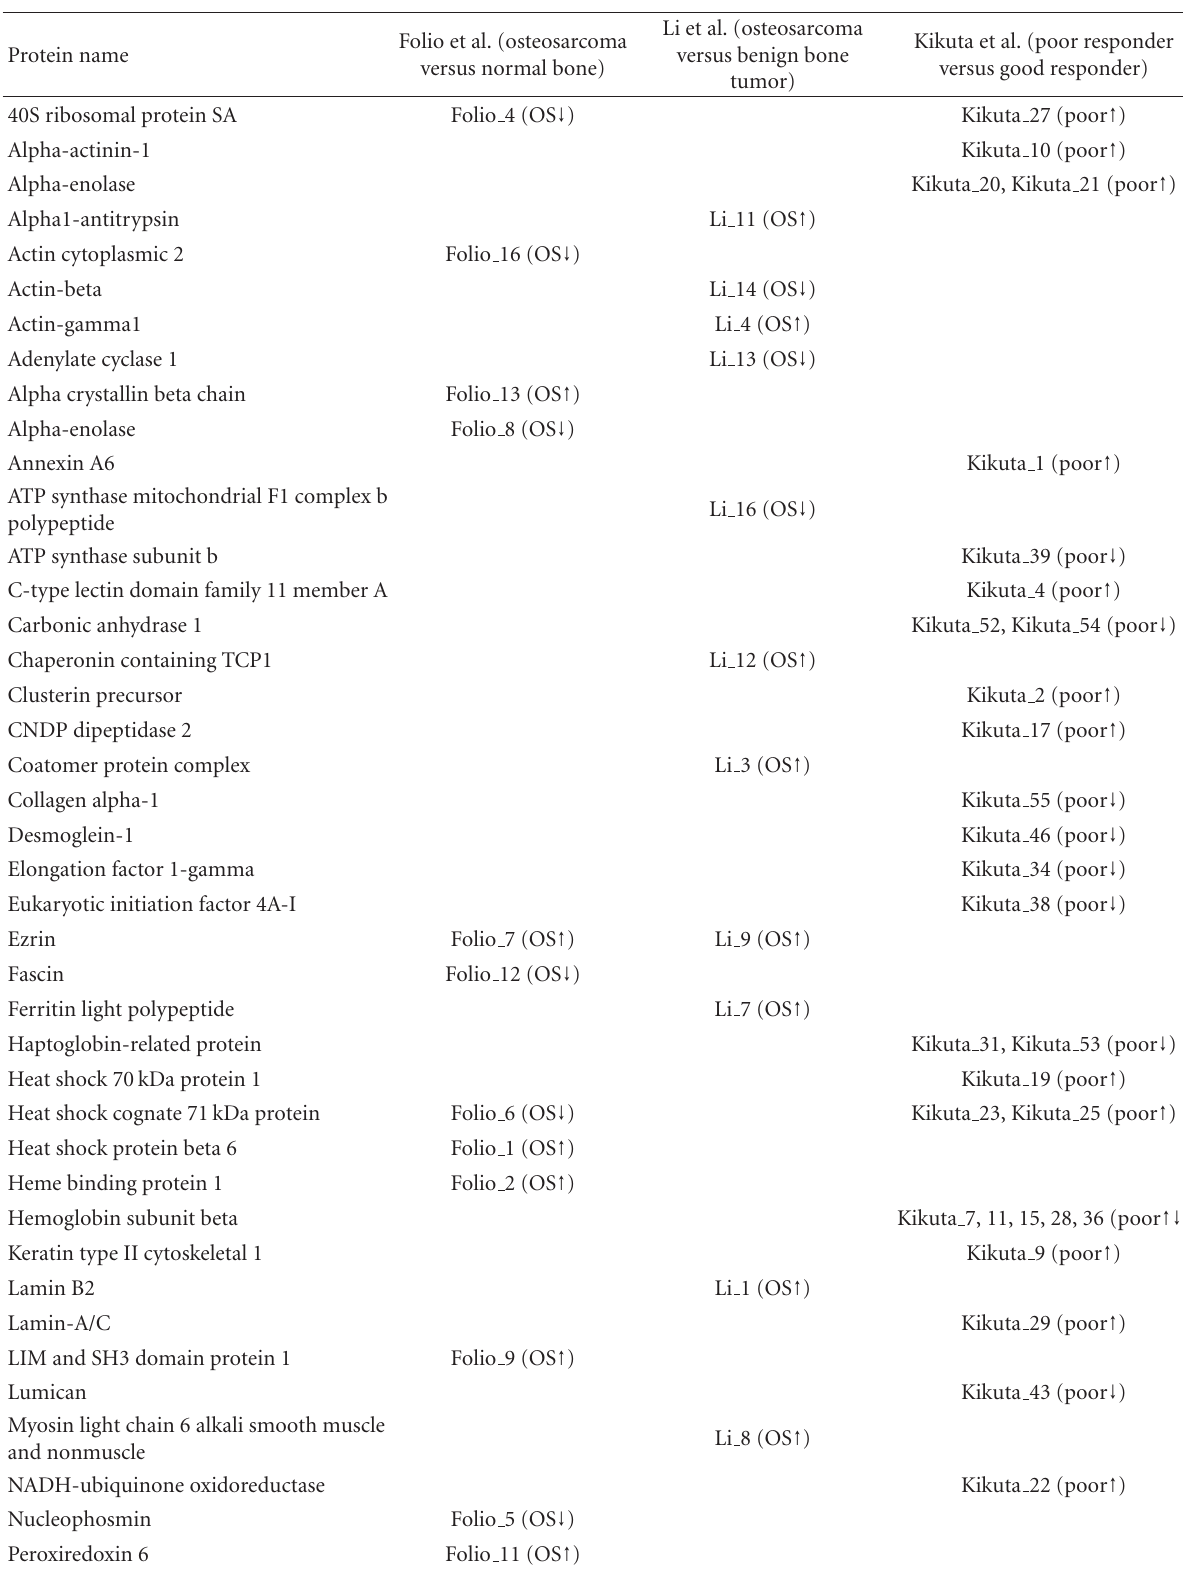
Table 3: Summay of protein expression studies using patient’s tissue samples of